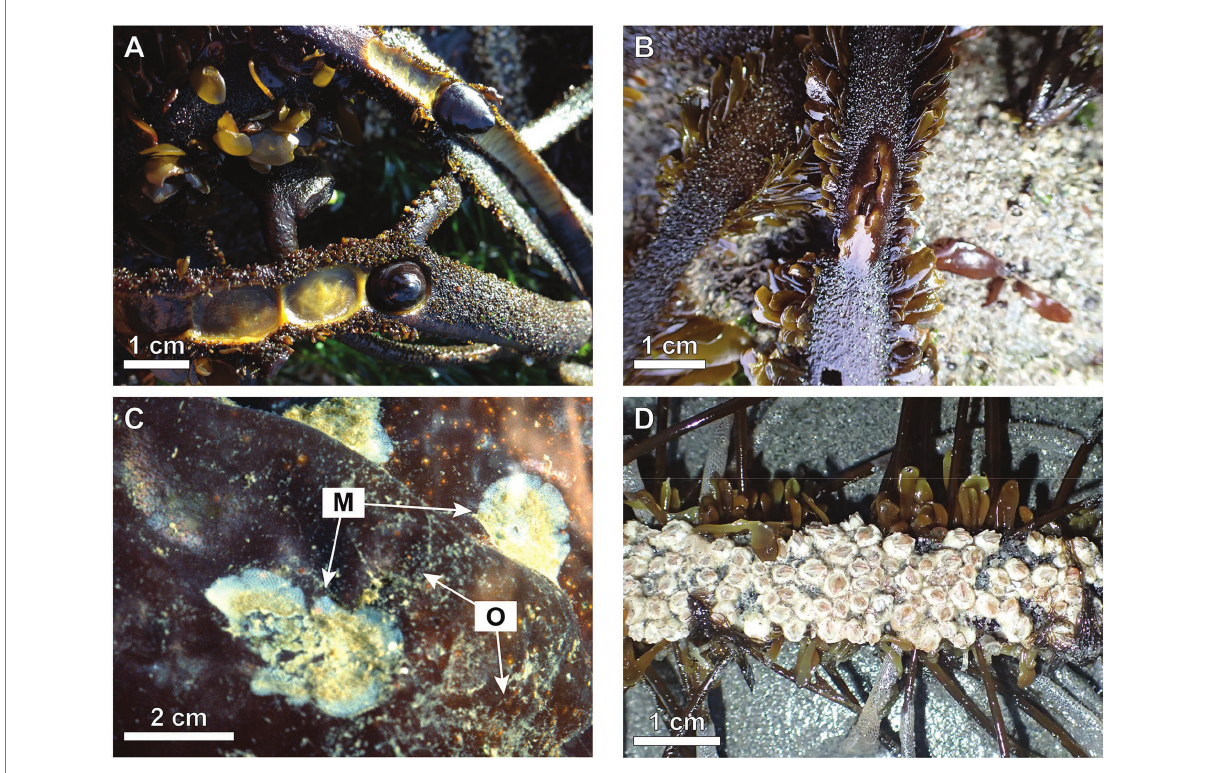
FIGURE 2 Examples of epibionts on macroalgae. (A) Damage of Egregia menziesii by herbivorous limpets, Discurria insessa . (B) Damage of E. menziesii by a burrowing, herbivorous amphipod. (C) Suspension-feeding encrusting bryozoans, Membranipora membranacea (M), and stoloniferous hydroids, Obelia longissima (O), growing on the blades of the red alga, Mazzaella splendens . (D) Barnacles encrusting a frond of E.